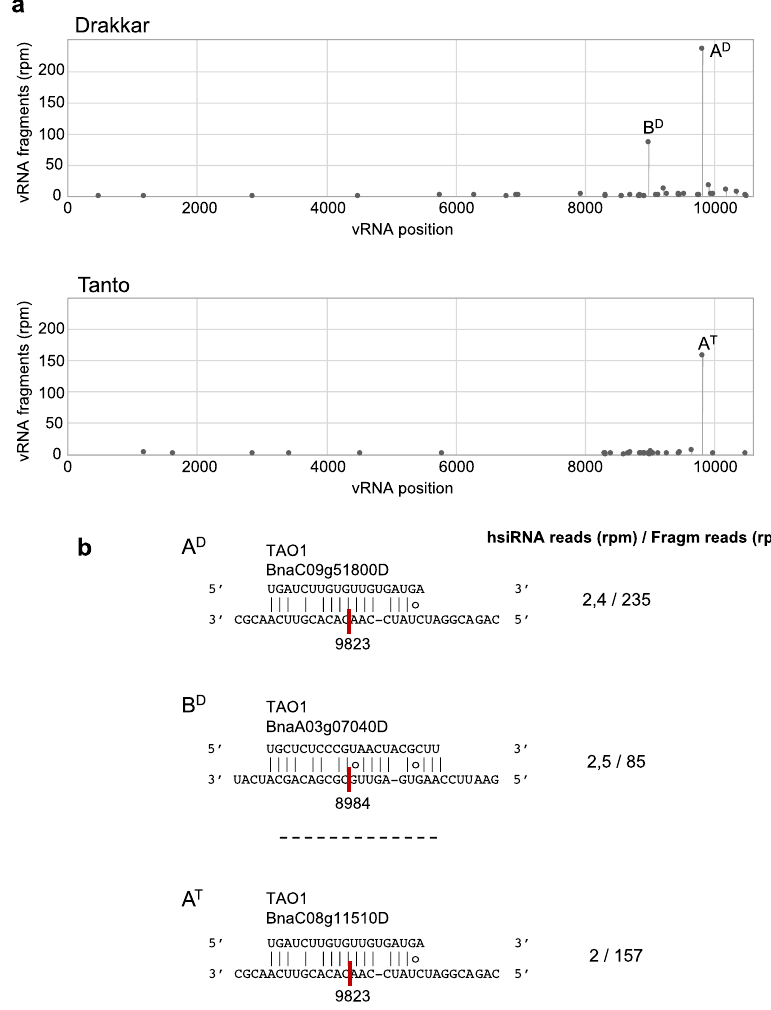
Fig. 6 Sequence-speci fi c cleavage of viral RNA at predicted hsiRNA-binding sites. a Target plots showing 5 ′ -signature abundance along the viral RNA identi fi ed through degradome sequencing of infected Drakkar and Tanto (top). Cleavage sites represented by the most abundant 5 ′ -degradome signatures within the target plots (referred to as A and B) involve siRNAs derived from genes predicted to encode the TIR-NB-LRR disease resistance protein TAO1. b Base-pair alignments between viral RNA and hsiRNA at A and B positions (bottom). Viral RNA cleavage sites and viral RNA cleavage positions are shown together with normalized abundance (r.p.m.) for the speci fi c hsiRNA and the normalized abundance (r.p.m.) of the corresponding viral RNA cleavage fragment in the degradome